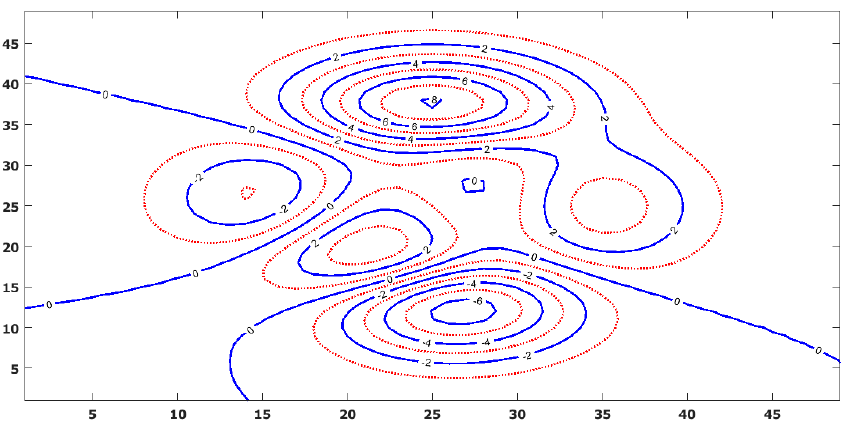
Figure 10. Temperature gradient for different objective functions.